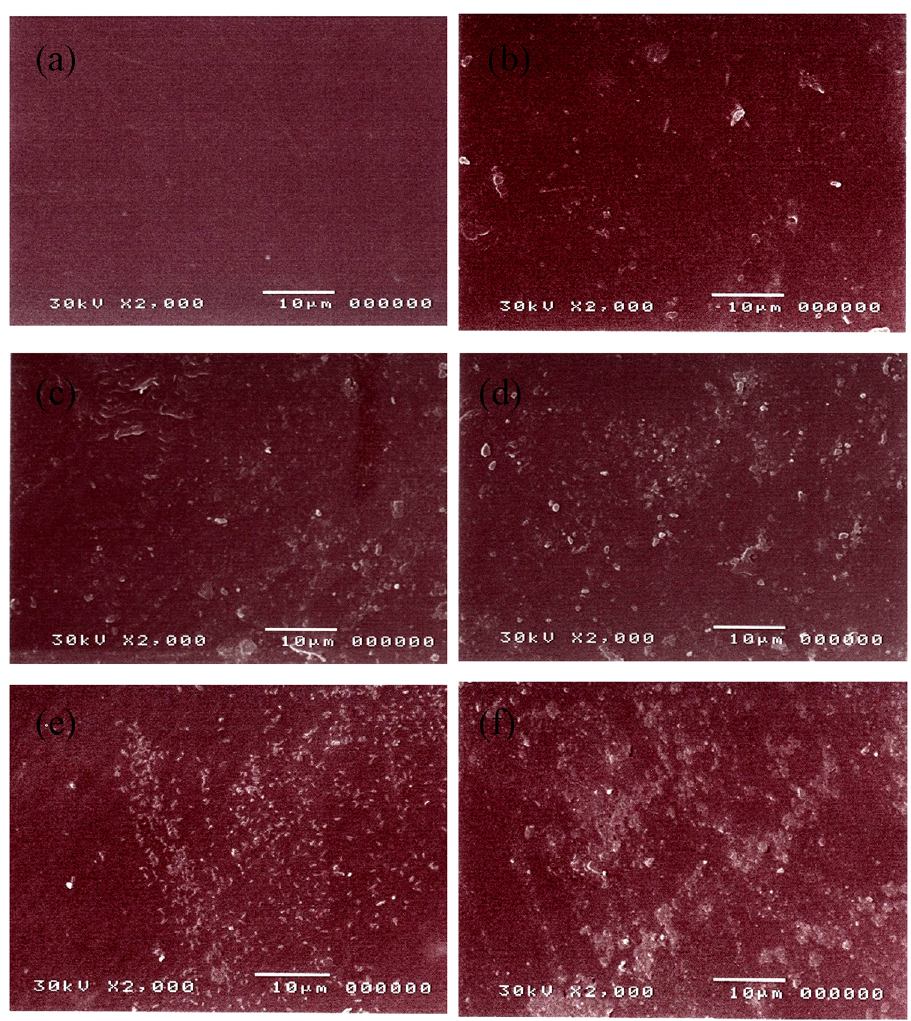
Figure 2: SEM images of ( a ) LDPE, ( b ) LDPE - g - MMA/Py, 35% graft, ( c ) 90%, ( d ) 118.5%, ( e ) 132%, and ( f )